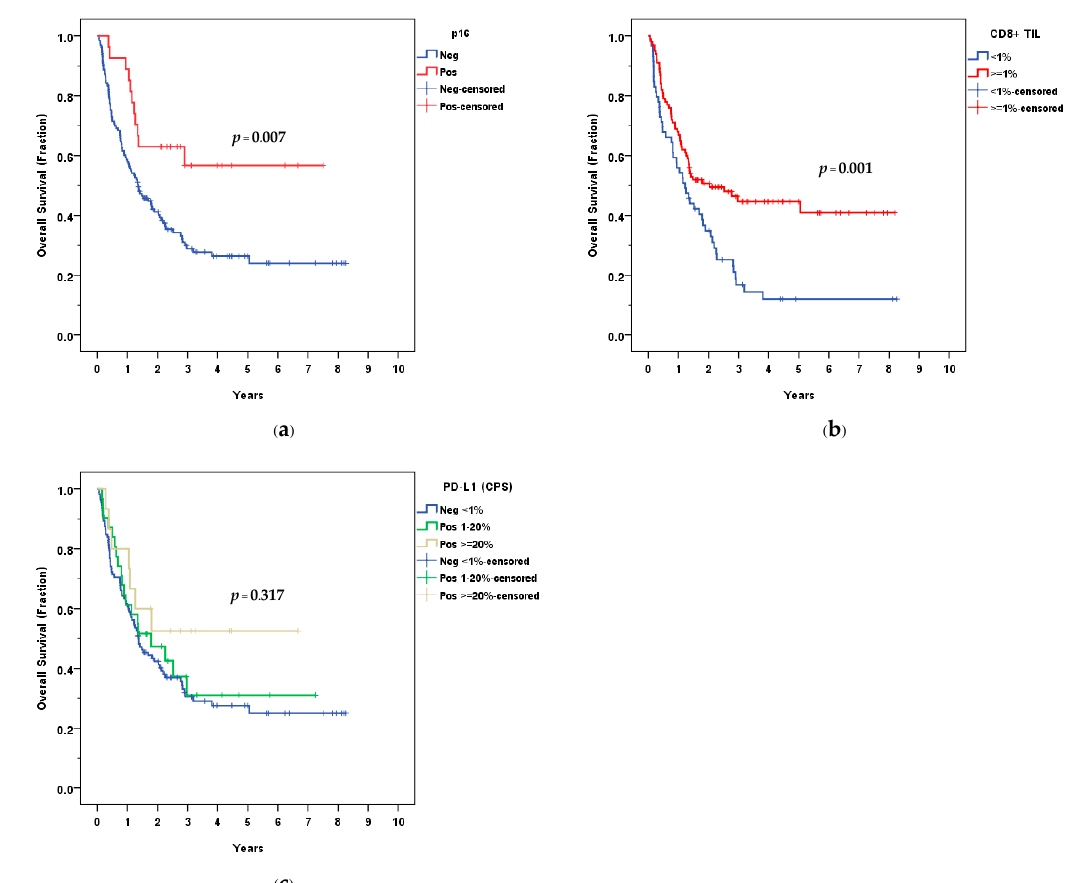
Figure 4 . Overall survival ( OS ) according to : ( a ) p16; ( b ) CD8 + TIL; ( c ) PD - L1 ( CPS ). Figure 4. Overall survival (OS) according to: ( a ) p16; ( b ) CD8+ TIL; ( c ) PD-L1 Table 4 . Cox regression model for overall survival ( OS ).